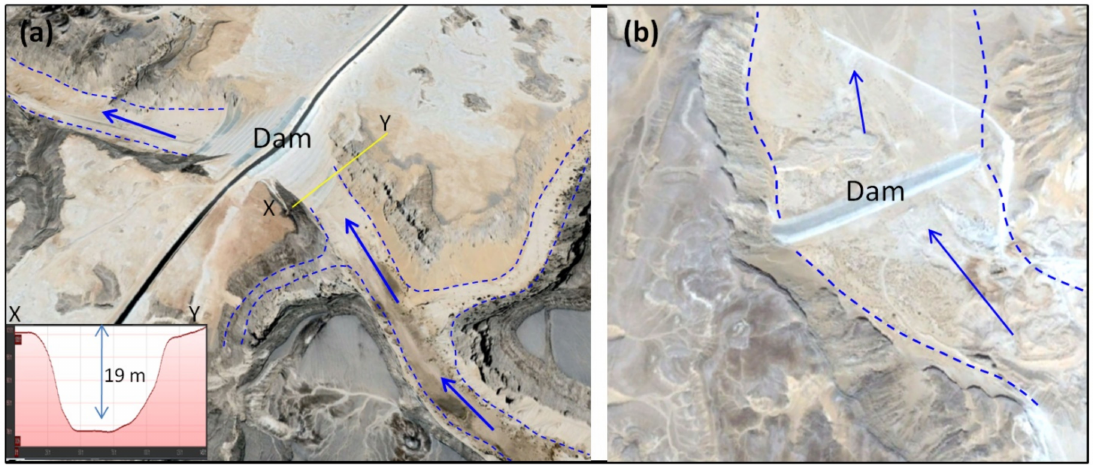
Figure 10. Dams along Wadi Asyuti: ( a ) W. Habib dam, ( b ) Wadi Hubara dam.